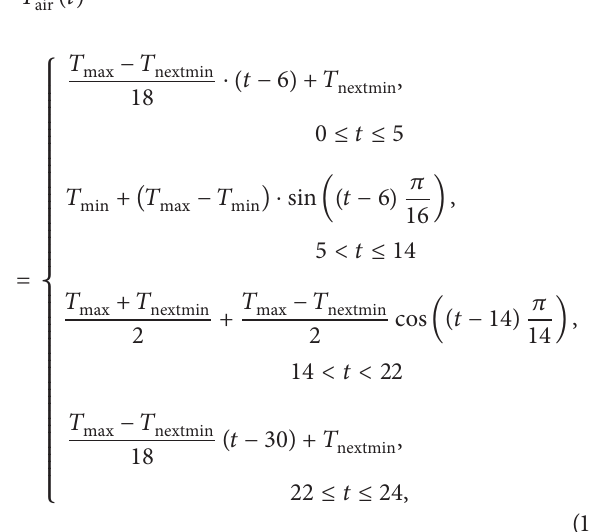
experience with fidelity to the reality representation.